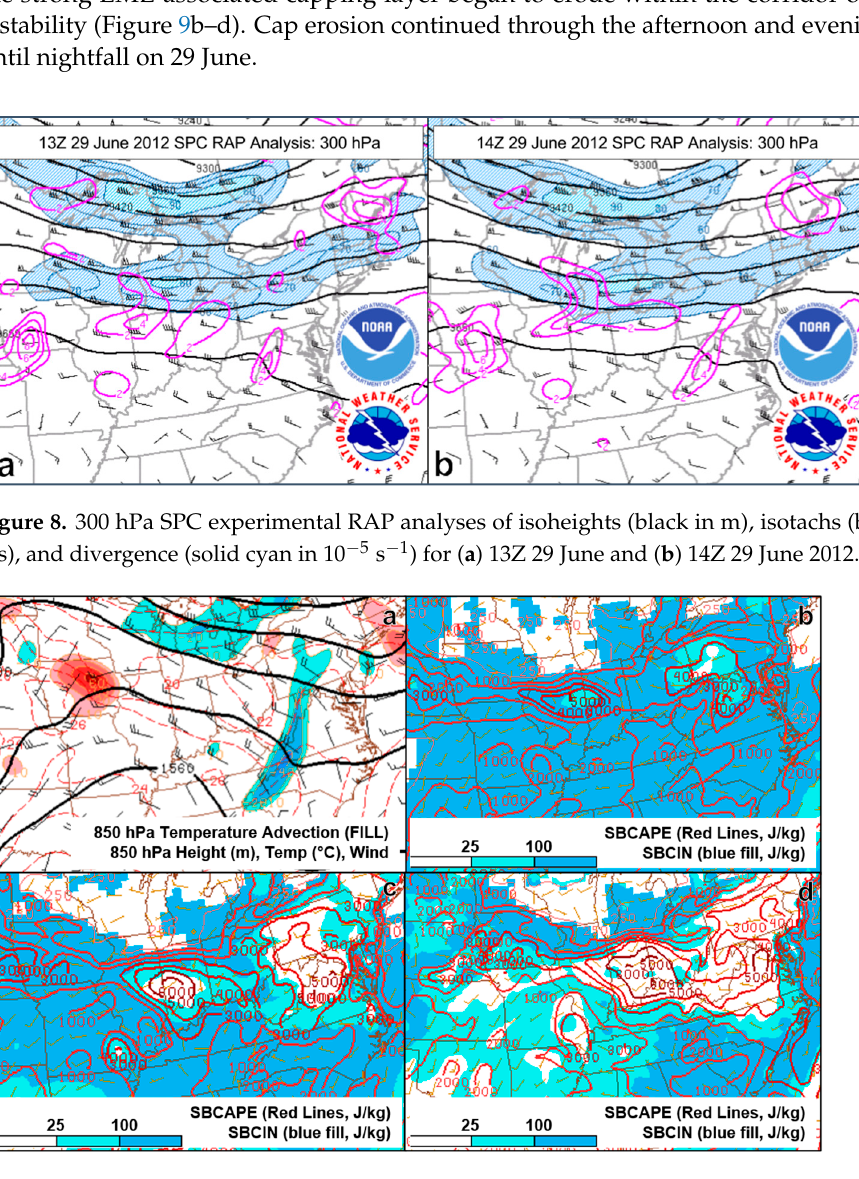
Figure 7. SPC experimental RAP analysis of 15Z 29 June 2012 for ( a ) surface-based CAPE (red iso- lines in J kg − 1 ) and CIN (blue shading in J kg − 1 ) values and ( b ) mixed layer (ML) CAPE and CIN values both in J kg − 1 .